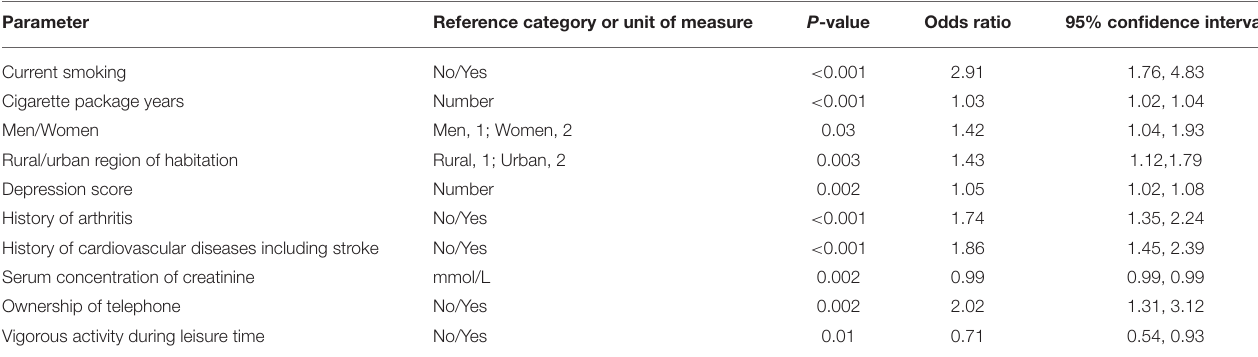
TABLE 4 | Associations (multivariate analysis) of the prevalence of airflow obstruction in both sexes in the Ural Eye and Medical Study, with the prevalence of airflow obstruction as the dependent variable and all other listed parameters as independent variable. Parameter Reference category or unit of measure